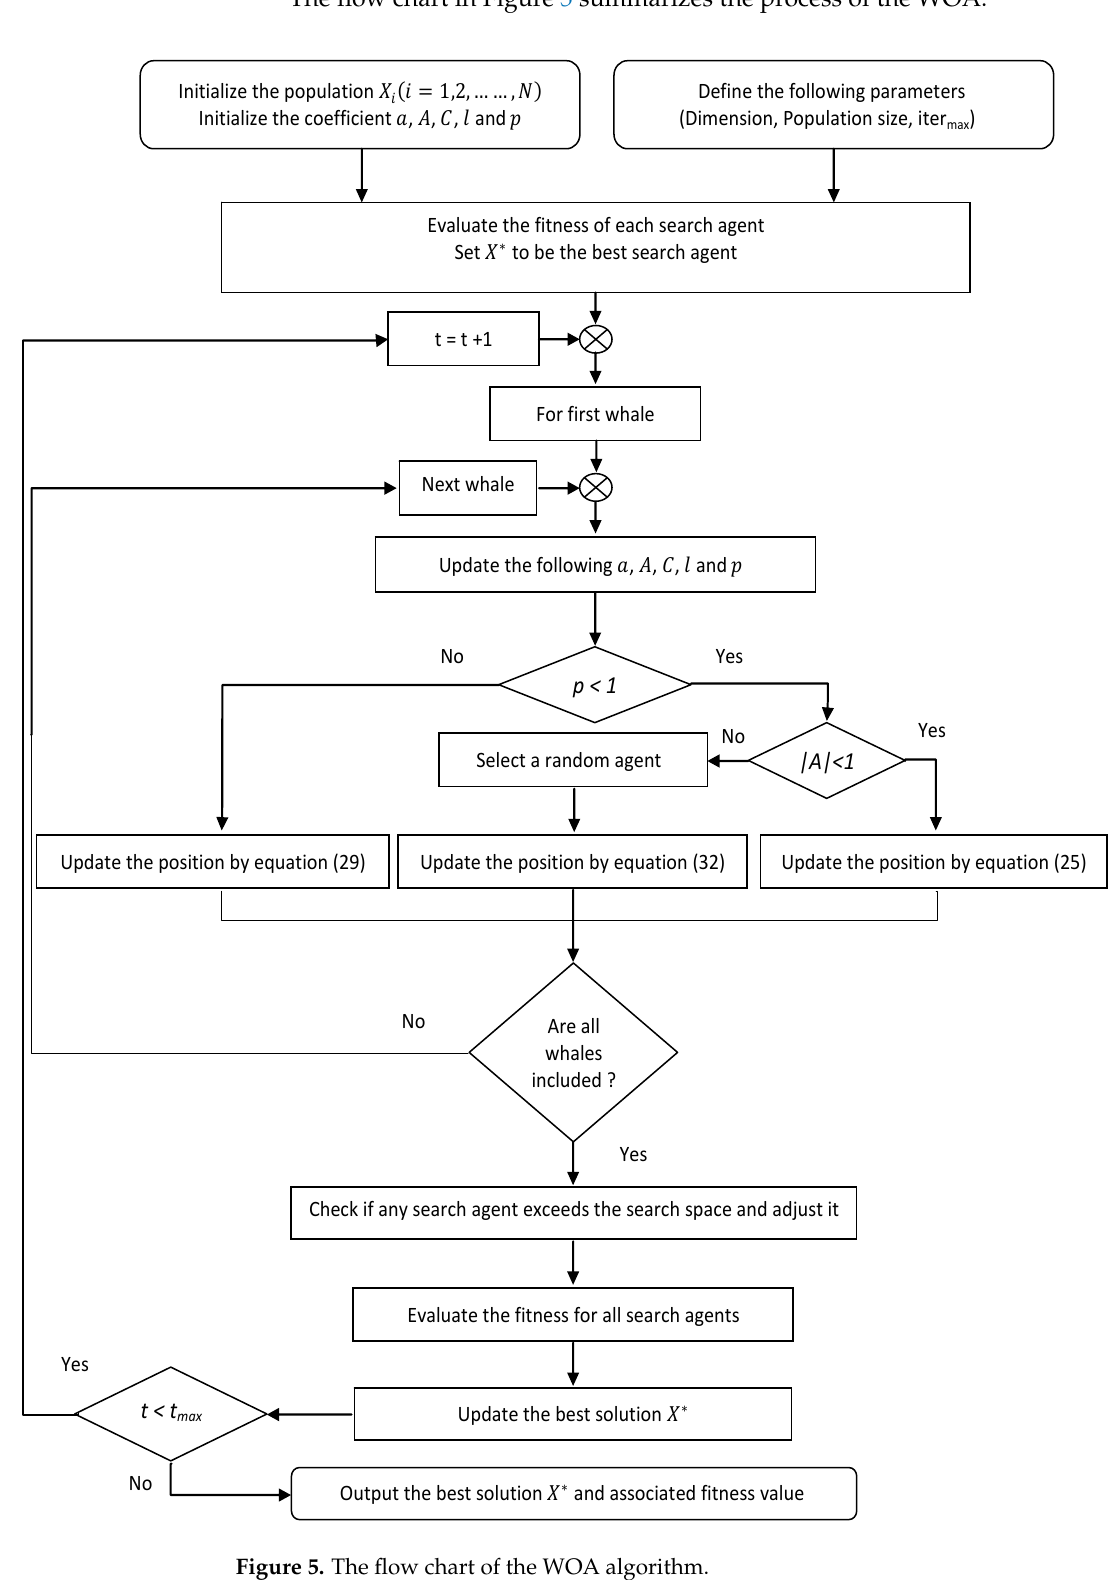
Figure 5. The flow chart of the WOA algorithm.